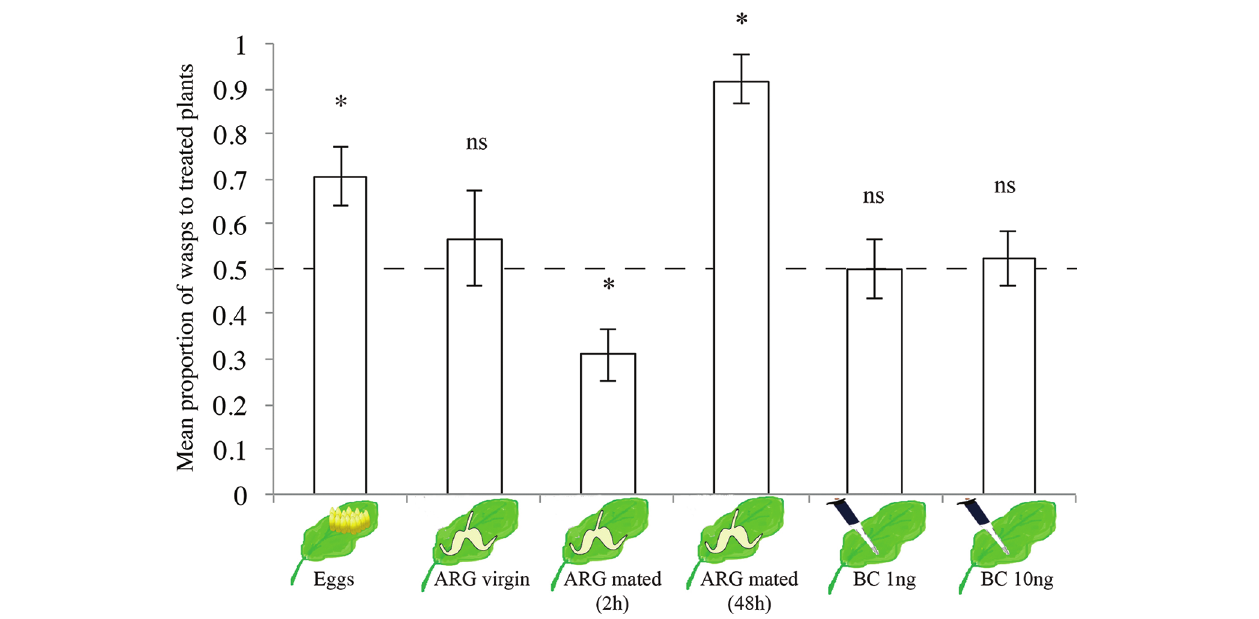
FIGURE 4 | Proportion (mean ± SE) of female Trichogramma evanescens wasps choosing volatiles of differently treated B. nigra plants when tested against untreated or solvent-treated control plants in a Y-tube olfactometer. Each treatment, (1) P. brassicae eggs 24 h after egg deposition, (2) ARG (of virgin P. brassicae females, (3) ARG of mated P. brassicae females 2 h after mating, (4) ARG of mated P. brassicae females 48 h after mating, (5–6) BC in two concentrations (1 and 10 ng/100 µ l ethanol) was replicated with four to seven plant pairs and 20 wasps per plant pair ( n = 80–140 wasps per treatment). ∗ p < 0.05, ns, not significant ( p > 0.05); one-sample t -test. The dashed line indicates 0.5 = no preference. For statistical analysis, data were first arcsine transformed and then back-transformed for